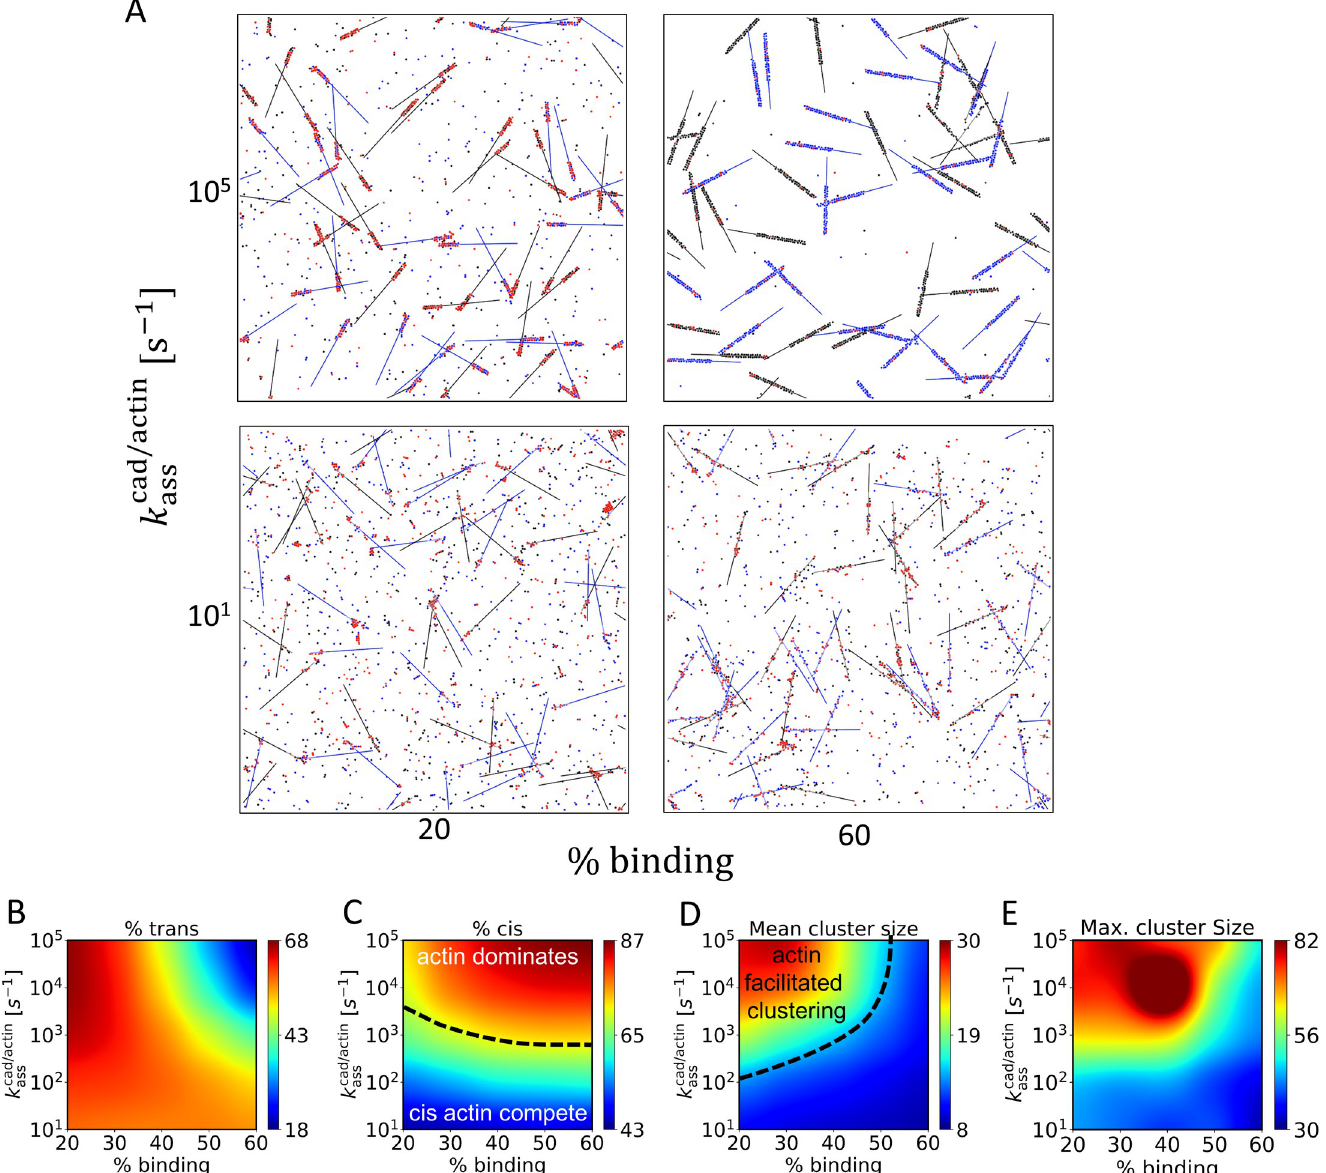
Fig 4. Cooperation and competition between F-actin binding and cis binding mediate cadherin clustering. (A) Snapshots of simulations at 100 s with two different association rate between F-actin and cadherin, k cad = actin , and two different percents of cadherin-binding region on F-actin. We used k cis ass ½ cad � ¼ 1200 m m (cid:0) 2 ; k cad = actin ¼ 0 : 1 s (cid:0) 1 . (B-D) With variations in k cad = actin and the fraction of binding region, we quantified (B) the fraction of cadherin molecules dis ass involved with trans dimer, (C) the fraction of cadherin molecules involved with cis interactions, (D) mean size of clusters formed by more than 4 cadherin monomers, and (E) maximum cluster